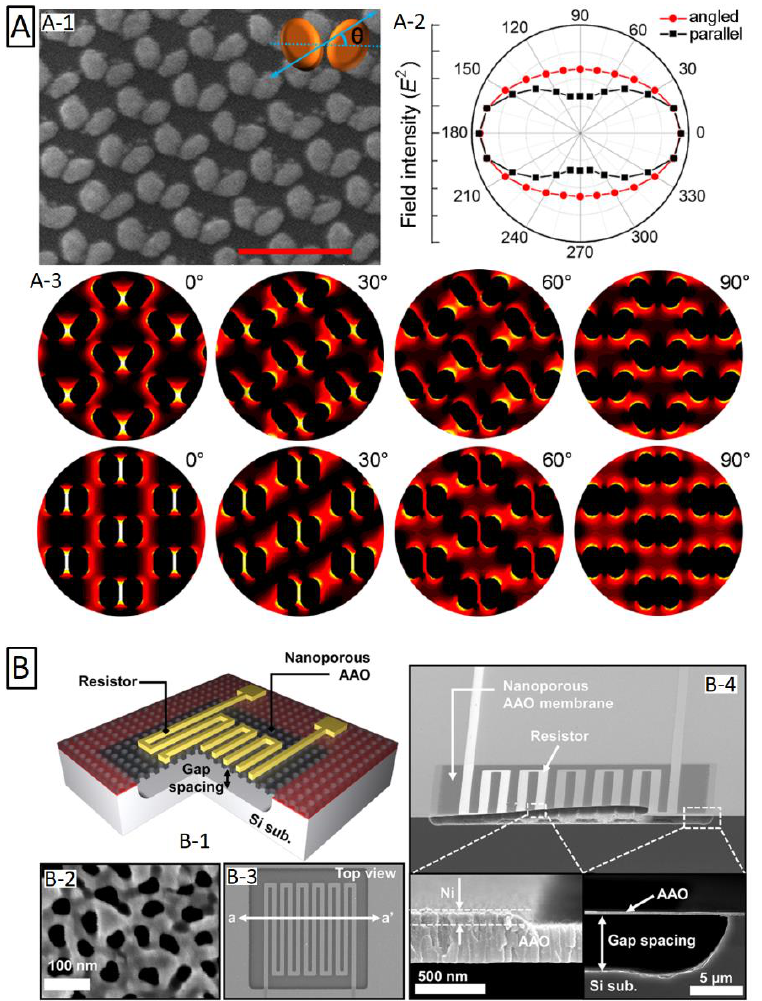
Figure 16. ( A ) Preparation of oriented nanoparticle dimers using NAA as a shadow mask. ( A-1 ) SEM image of ellipsoidal dimers angled at 60°; ( A-2 ) calculated electric field density with regards to dimers’ angular orientation; and ( A-3 ) FDTD simulation of electric field distribution of dimers at different conformation. Reprinted (adapted) with permission from [204]. Copyright 2017 American Chemical Society. ( B ) ( B-1 ) Schematic of Pirani sensor and SEM images of ( B-2 ) NAA membrane top view, ( B-3 ) Pirani sensor top view, and ( B-4 ) cross-section captures of fabricated device. Reprinted (adapted) with permission from [214]. Copyright 2016 AIP